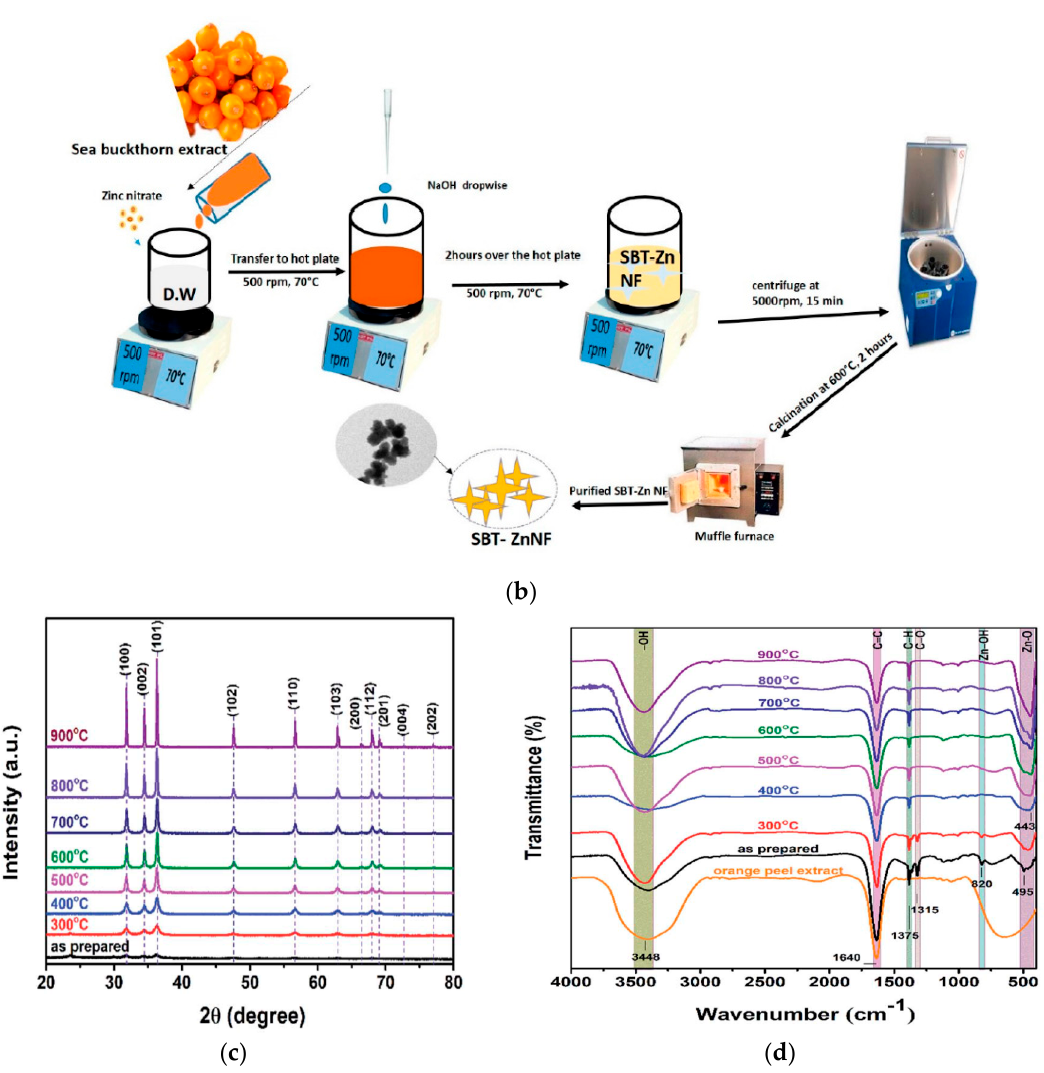
Figure 14. ( a ) Proposed reaction mechanism between functional groups of grapefruit peel extract and zinc ions from zinc sulfate in forming zinc-ligand complex and ZnO NPs after drying in an oven at 150 °C. Reproduced from [217] under the Creative Commons Attribution License. ( b ) A schematic showing biosynthesis of ZnO nanoflowers (NFs) using Zn(NO 3 ) 2 .6H 2 O and sea buckthorn (SBT) fruit extract. Reproduced from [220] under the terms of the Creative Commons Attribution License. ( c ) X-ray diffraction patterns showing the wurtzite structure of as-synthesized ZnO nanoparticles calcined at different temperatures. ZnO NPs are biosynthesized from Zn(NO 3 ) 2 .6H 2 O and orange peel extract. ( d ) Fourier transform infrared spectra of orange peel extract and the as-synthesized ZnO NPs heat treated at different temperatures. Reproduced from [219] under the terms of the Creative Commons Attribution-NonCommercial 3.0 Unported License.